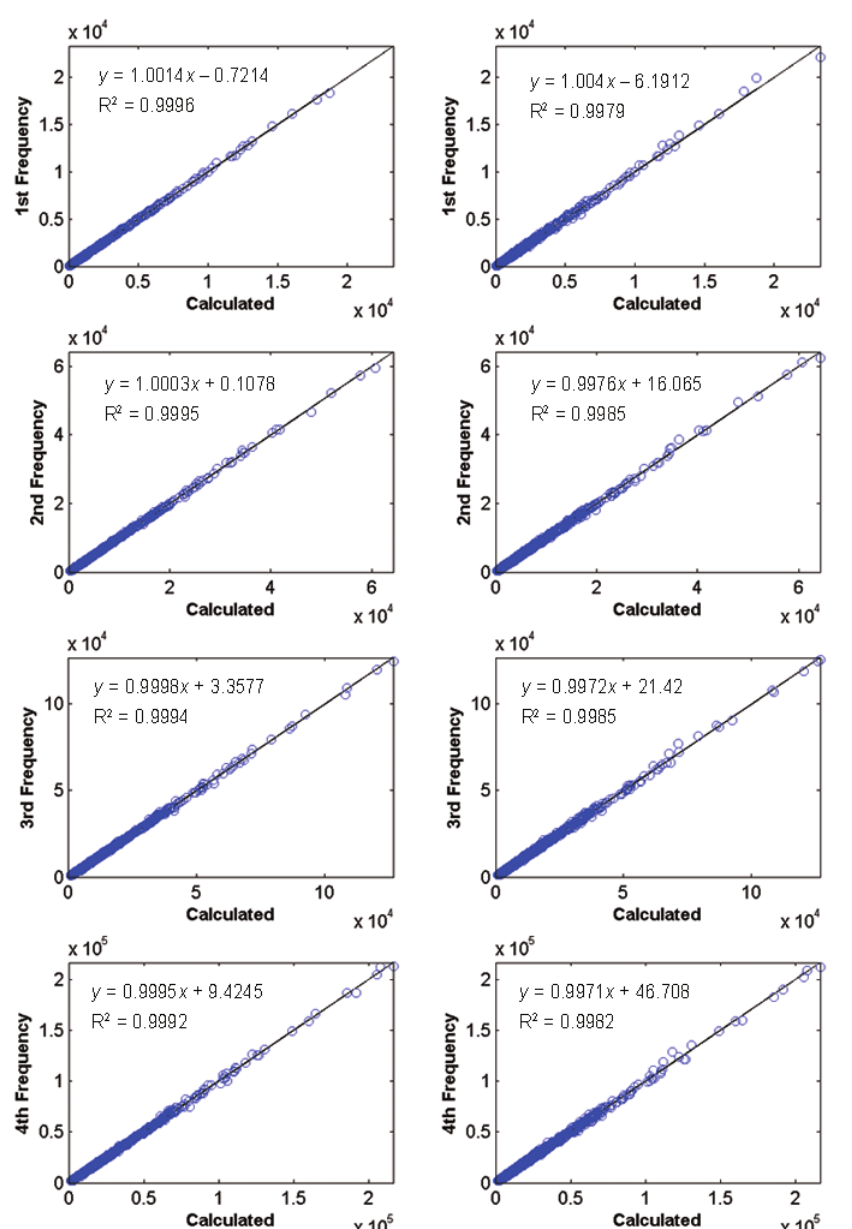
Fig. 5. Calculated and modelled frequencies by RBNN (left) and MLP (right) models in test phase